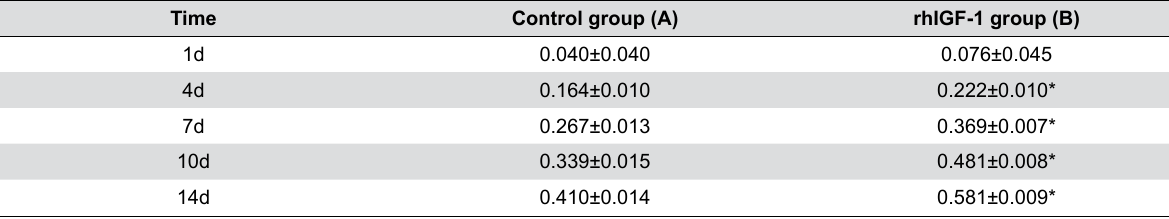
Figure 3- Changes of the number of osteoclasts in periodontal ligament of rats in two groups from 1 to 14 days after orthodontic force was applied. *: p<0.01, compared to the control Table 1- Tooth movement of two groups (mm, mean±sd, n=8)